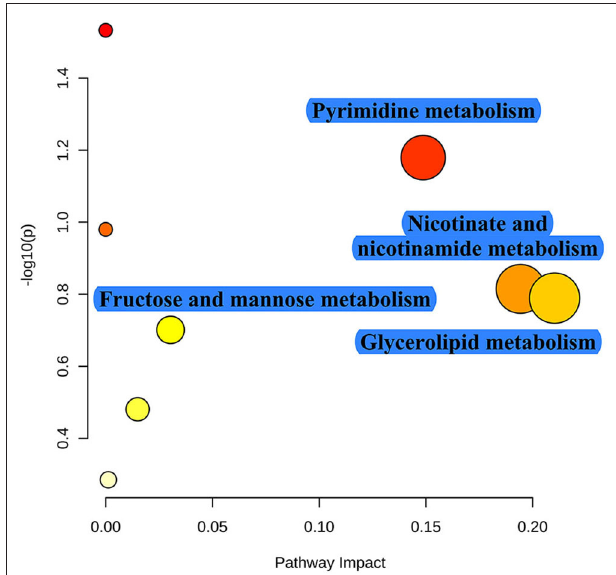
FIGURE 5 | Pathway enrichment of these significant differential metabolites identified between the FA and TRF groups. The x-axis marks the pathway impact and the y-axis represents the pathway enrichment. Each node marks a pathway, with larger sizes and darker colors representing higher pathway enrichment and pathway impact